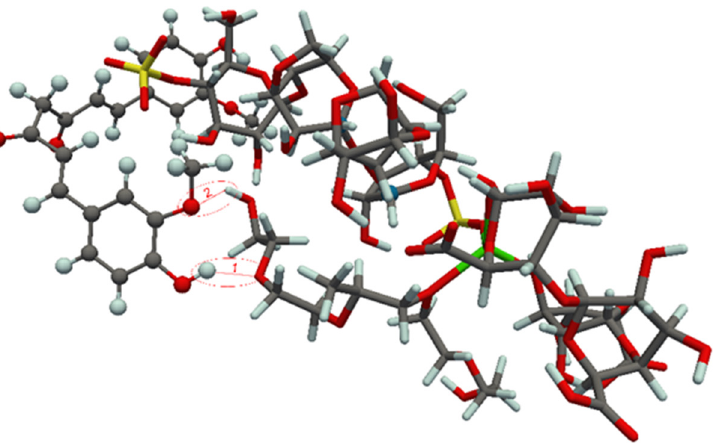
Figure 9. Optimized structure of curcumin-carrier complex. Hydrogen bonds are denoted by red dashed lines (1 and 2). For the sake of clarity, the ball-and-stick and licorice visualization models were used for molecular structures of the drug and drug carrier, respectively.